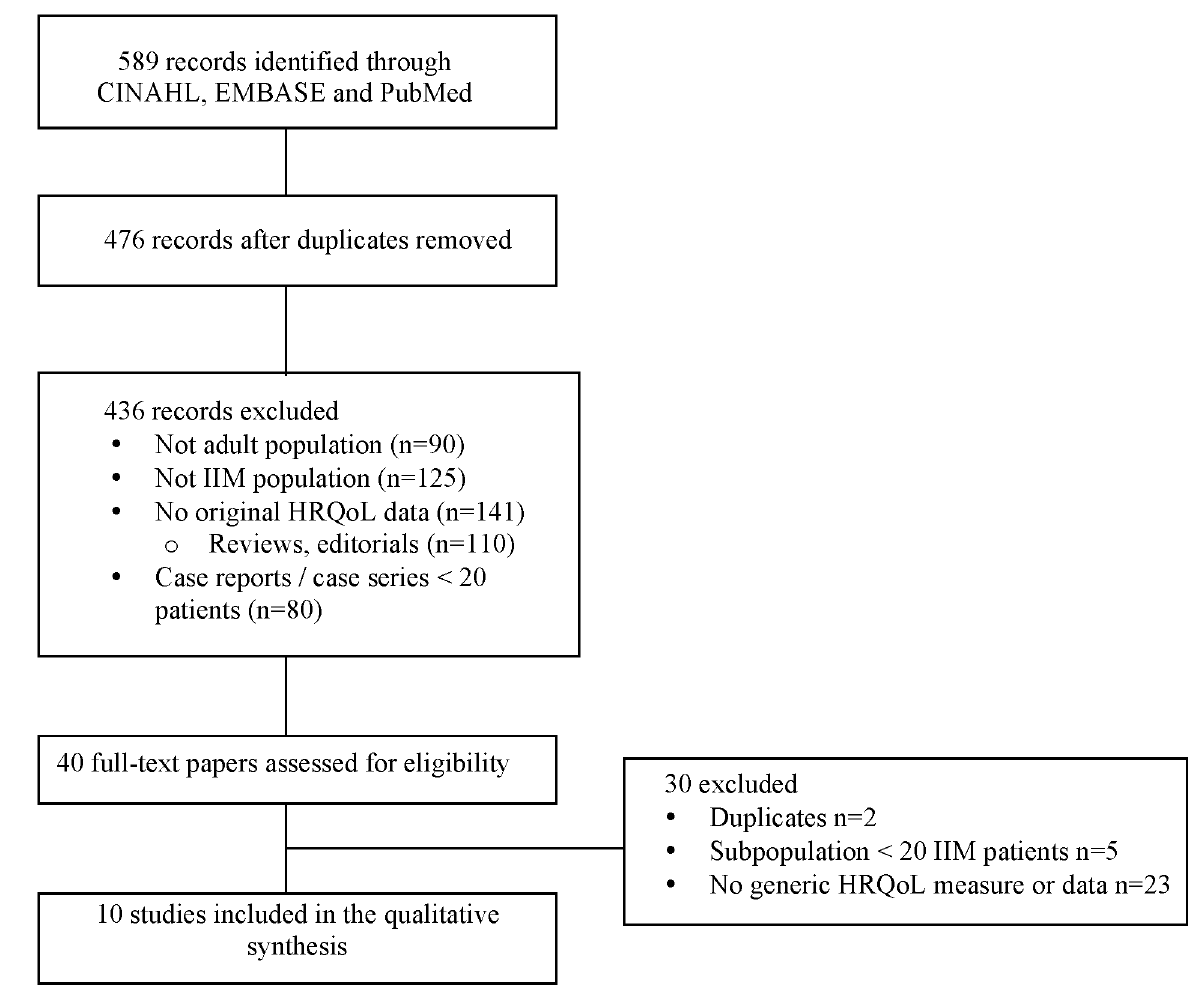
Fig 1. Flow diagram of study